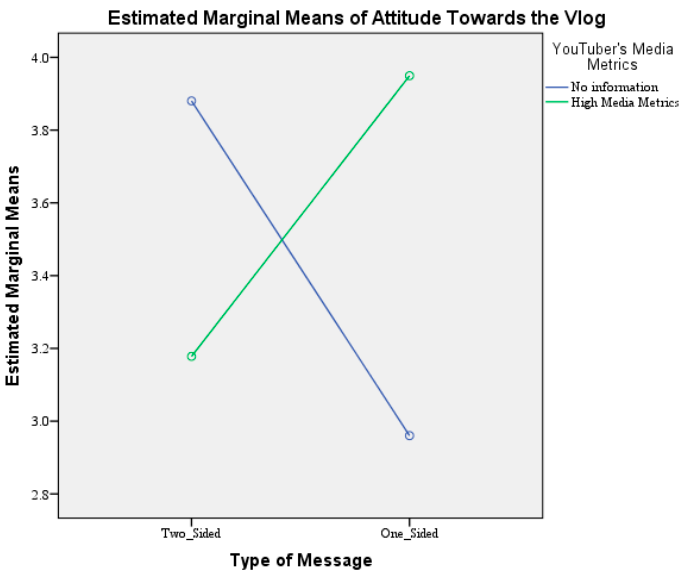
Figure 2. The effect of type of message on attitude towards the vlog moderated by the YouTuber’s